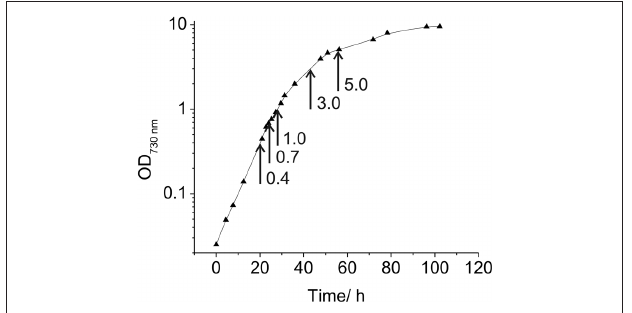
Figure 1 | growth curve for Synechococcus 7002. Growth curve under “standard” conditions in medium A + indicating the OD samples for transcription analyses were taken